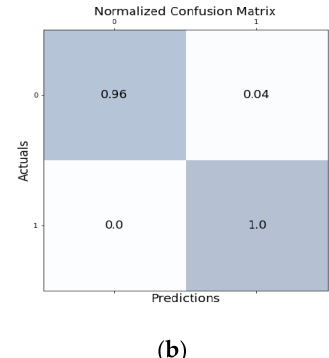
Figure 5. ( a ) Confusion matrix and ( b ) normalized confusion matrix for the proposed HNIDS model for MCC.